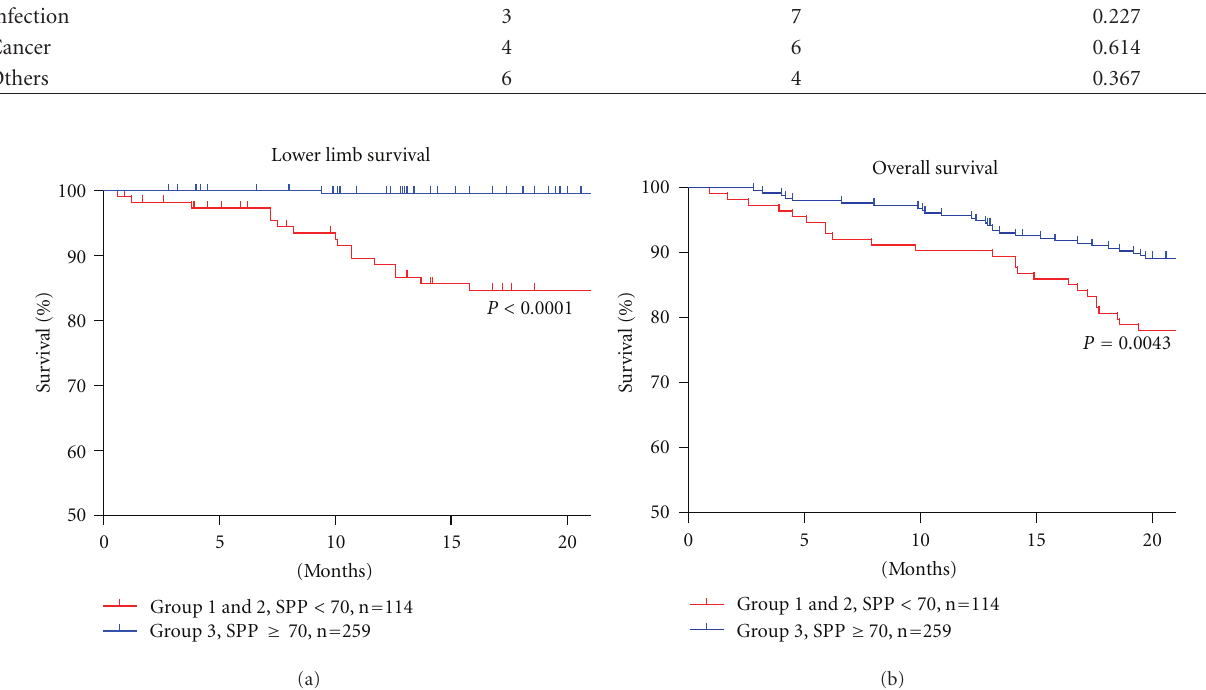
Figure 2: Lower limb survival and overall survival in Groups 1 and 2 versus 3. Patients were recategorized according to their SPP values: Groups 1 and 2: < 70 and Group 3: SPP ≥ 70. Lower limb survival and overall survival were significantly poorer in Groups 1 and 2 ( P < 0 . 0001) compared with those in Group 3 ( P = 0 .